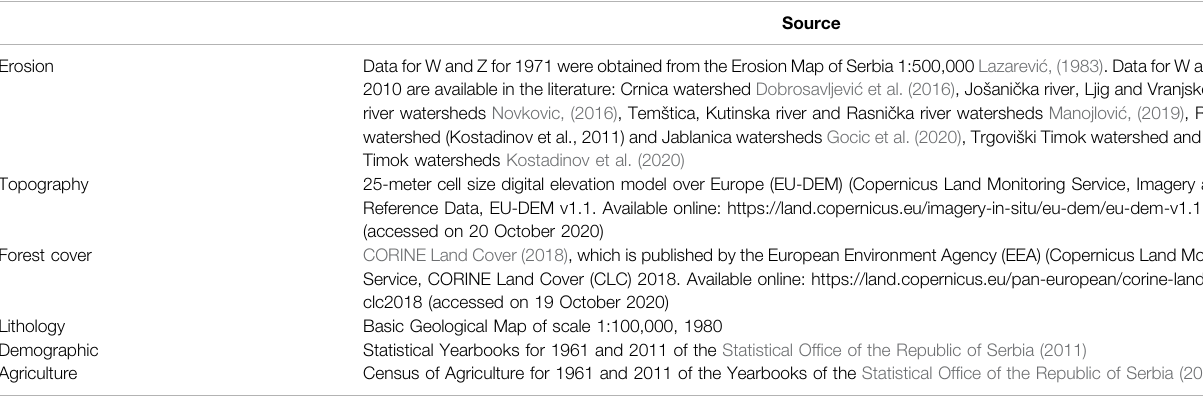
TABLE 3 | Basic dataset sources used in the study.